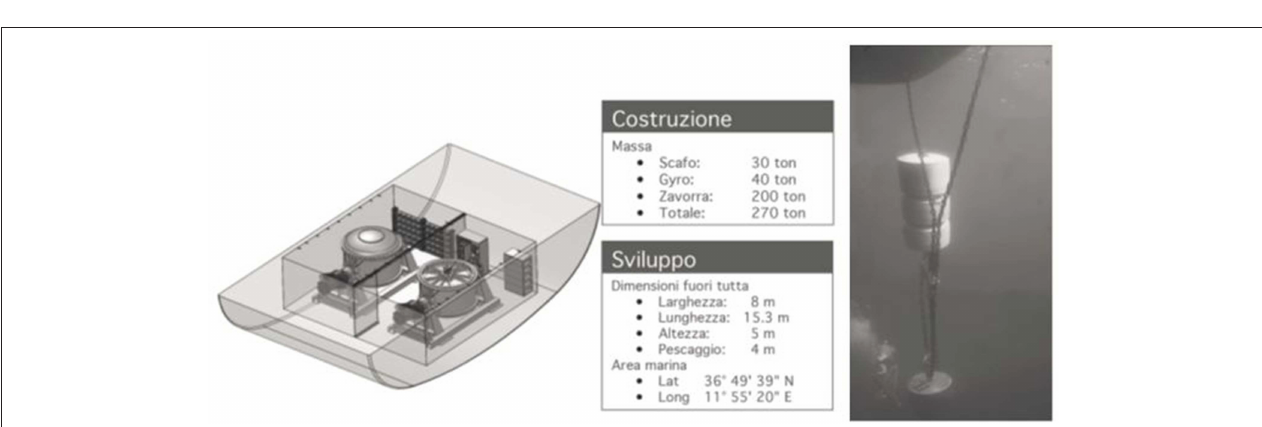
FIGURE 12 | 1:45 PeWEC scale device (Left) and schematic representation of PeWEC (Right) .